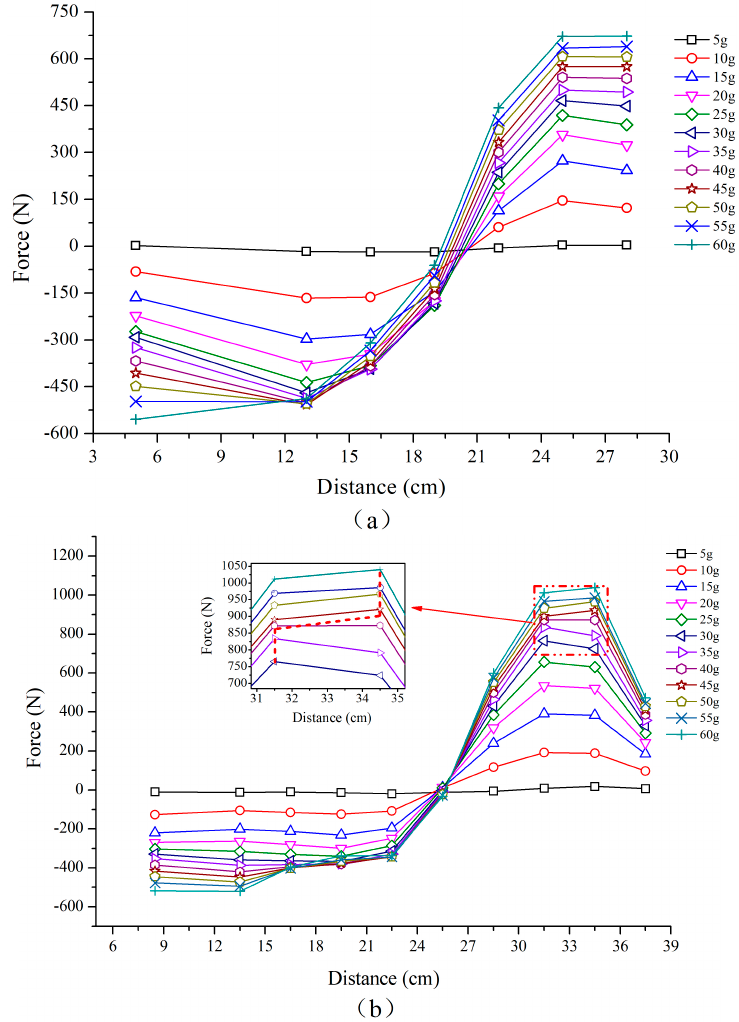
Figure 9. Axial force of anchors ( a ) The upper anchor ( b ) The lower anchor .